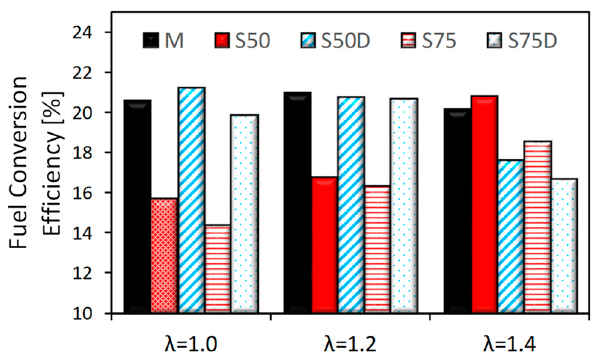
Figure 8. Coefficient of variation of indicated mean effective pressure for M, S50, S50D, and S75D at fixed SA ( − 7 CAD ATDC) and air-fuel dilution from 1.0 to 1.4.